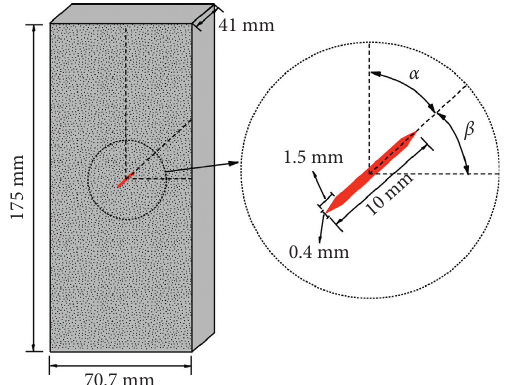
Figure 12: Geometric dimensions of rock-like material samples with preexisting crack.